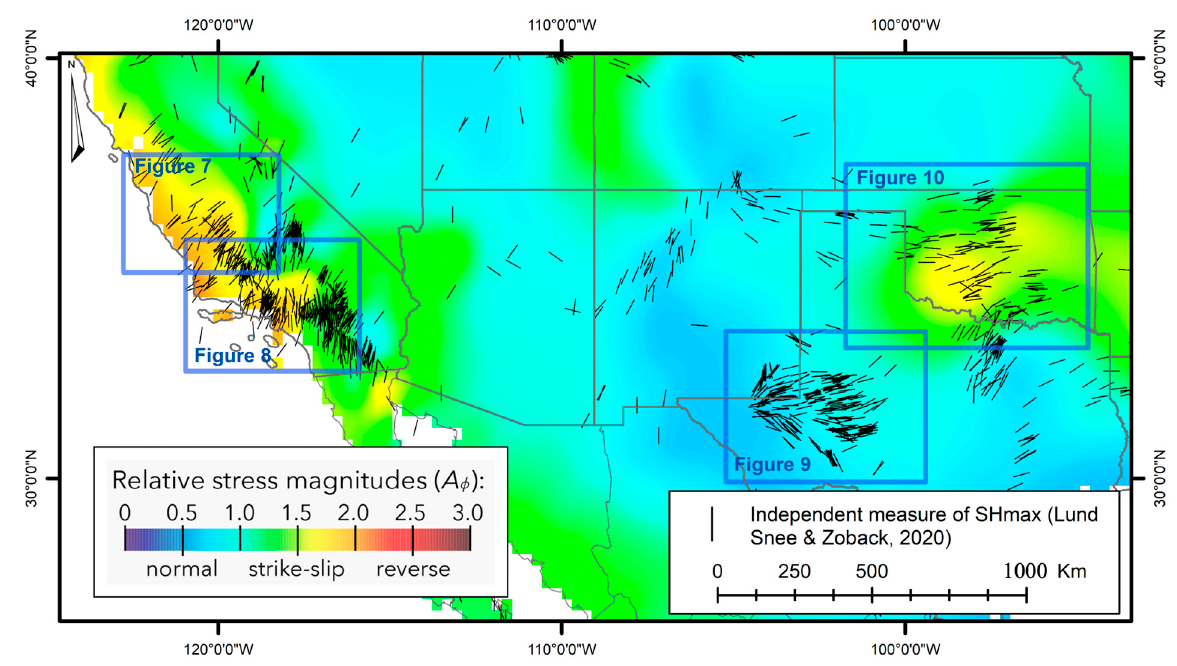
Figure 1. The four regions analyzed. The black lines are the orientations of S Hmax , and the colors are the relative stress magnitudes (A φ ) based on [3,4]. An A φ value of 0 corresponds to an extensional stress regime and 3 corresponds to compressive.